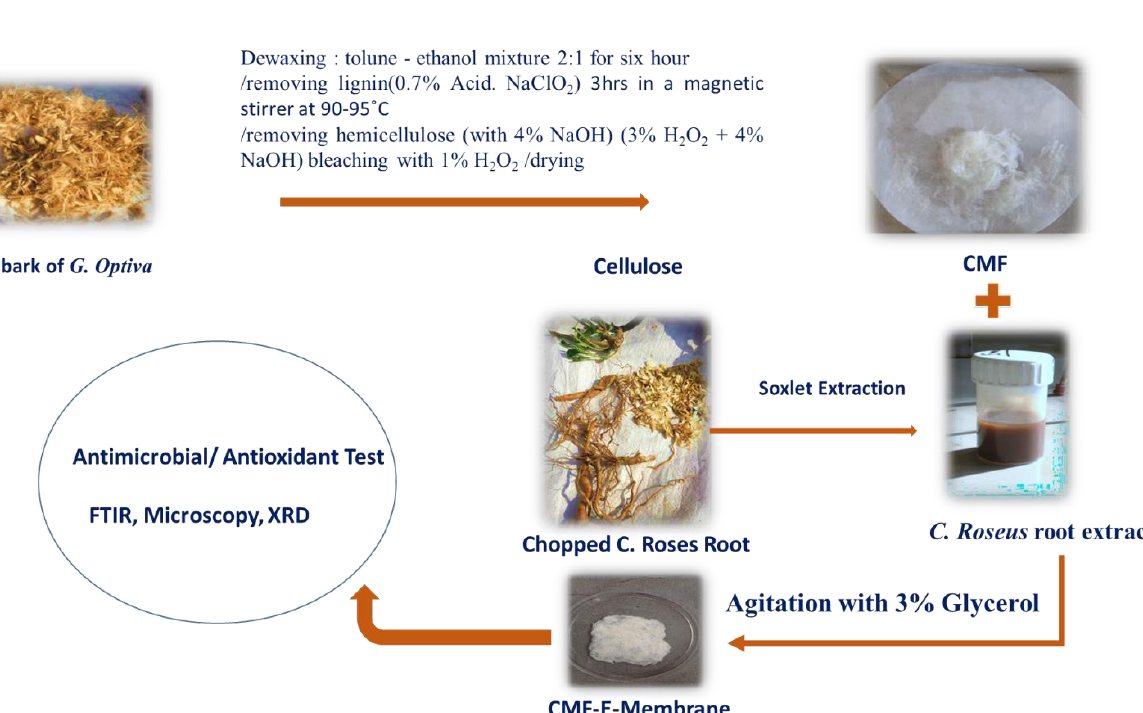
Figure 1. Schematic illustration showing the extraction of cellulose microfibers (CMF) from G. optiva fibres GOFs and encapsulation of C. Roses root extract to synthesise a cellululose micro fibre membrane (CMF-E).